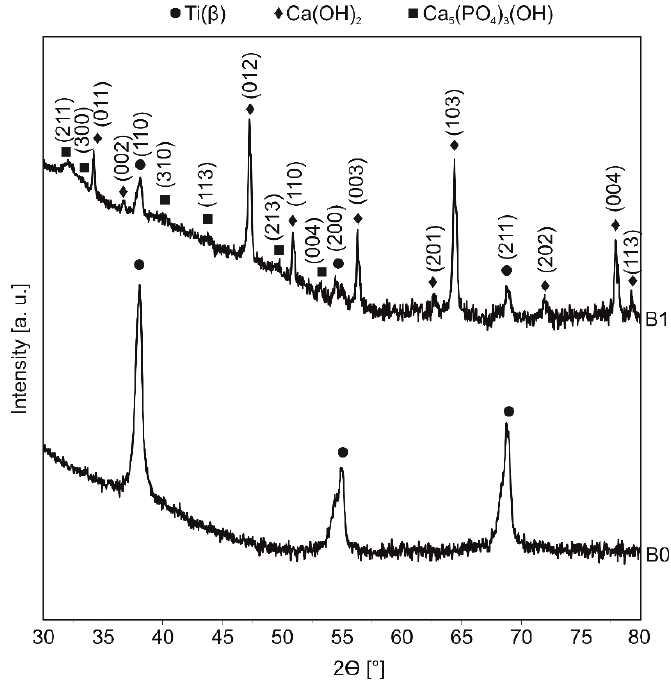
Figure 1. XRD spectra of Ti23Zr25Nb alloy electrochemically modified in 0.042M Ca(NO 3 ) 2 + 0.025M (NH 4 ) 2 HPO 4 + 0.1M HCl bath with the voltage of −10 V and the time of 60 min (B1). The base Ti23Zr25Nb (B0) alloy was used as a reference material.